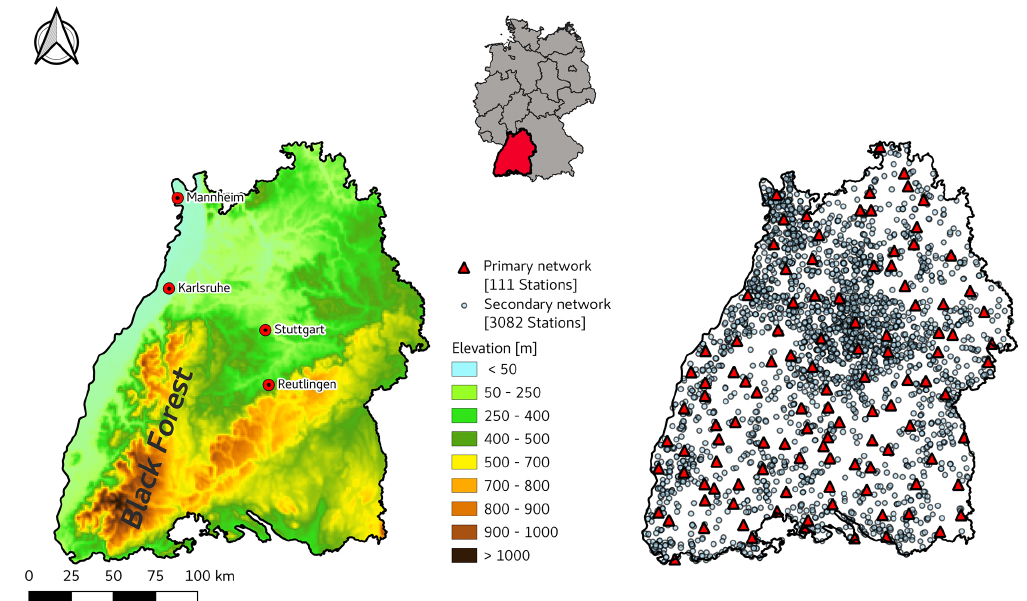
Figure 1. Map of the federal state of Baden-Württemberg, showing the topography and the location of the DWD (primary) and Netatmo (secondary) gauges.